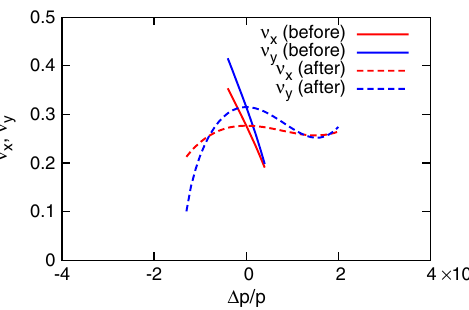
FIG. 10. Chromatic dependence of the fractional betatron tunes before and after the linear chromaticity compensation using the DS approach.